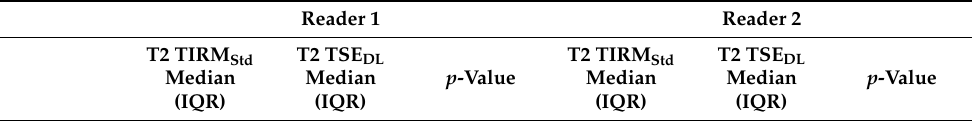
Table 4. Detailed results of the image